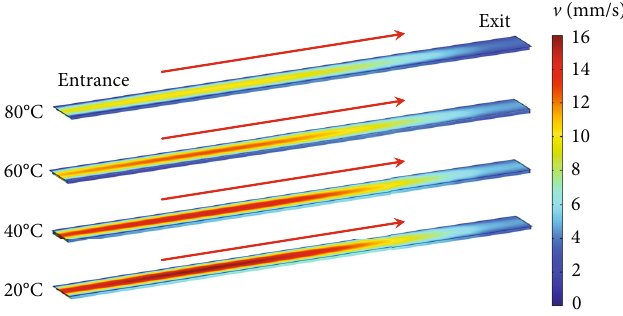
Figure 15: Velocity distribution at the time of the grouting completion in the 75m length